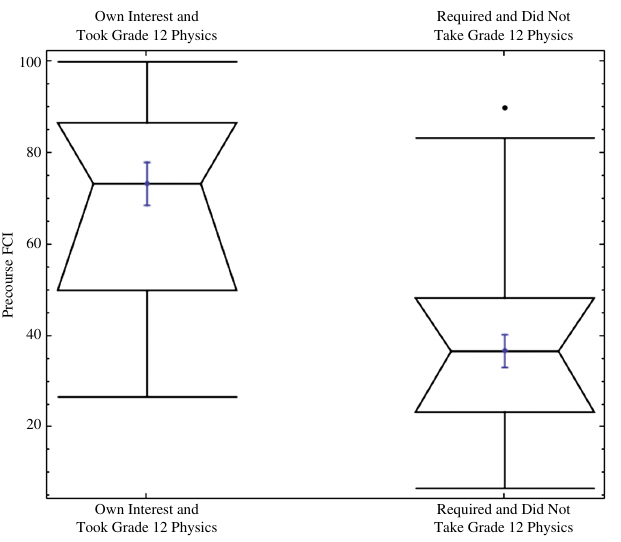
FIG. 6. Two different categories of students and their precourse FCI scores.